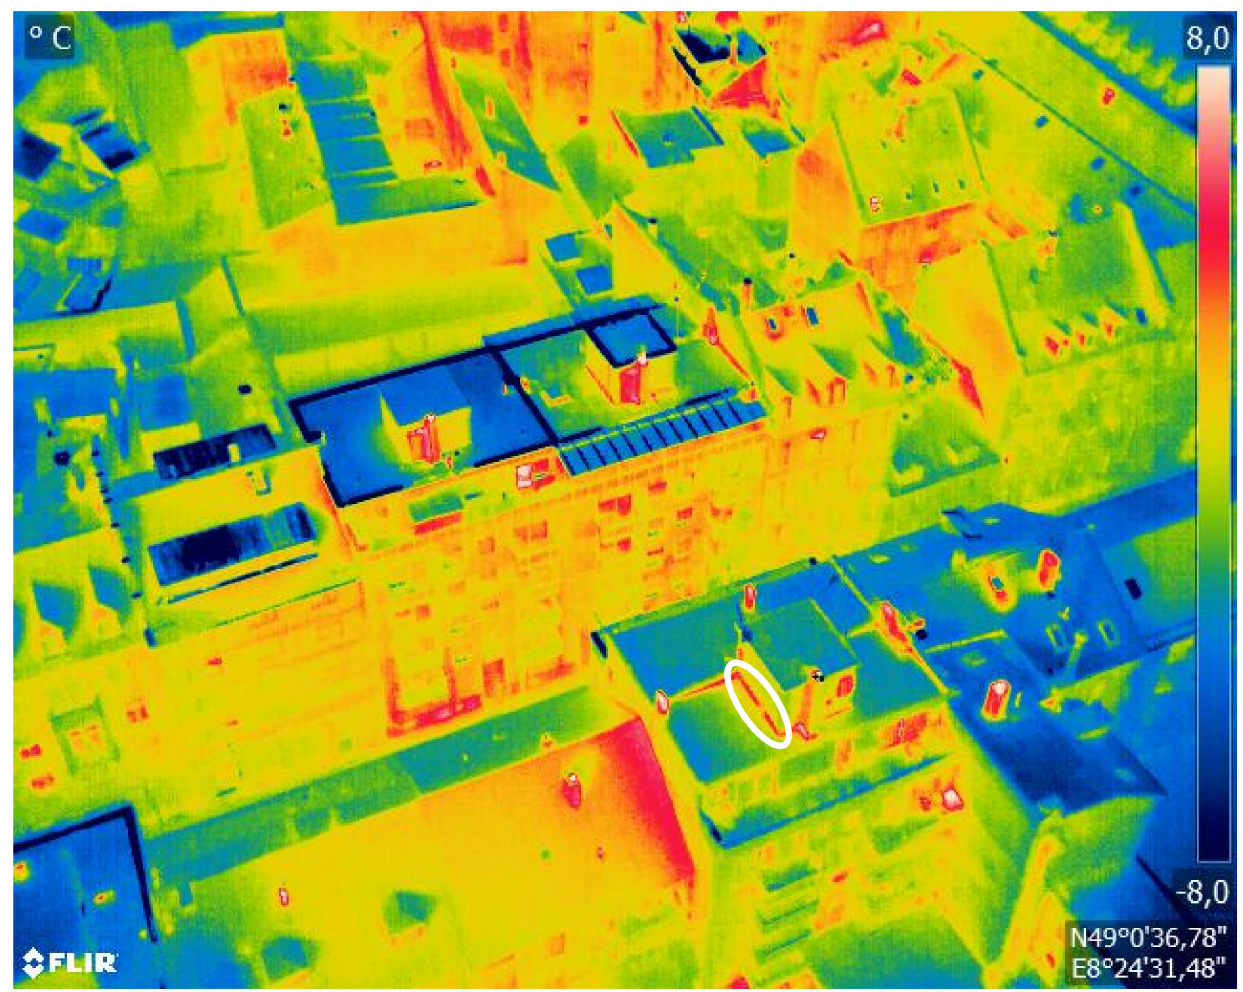
Figure A21. Example: thermal bridge of a staggered